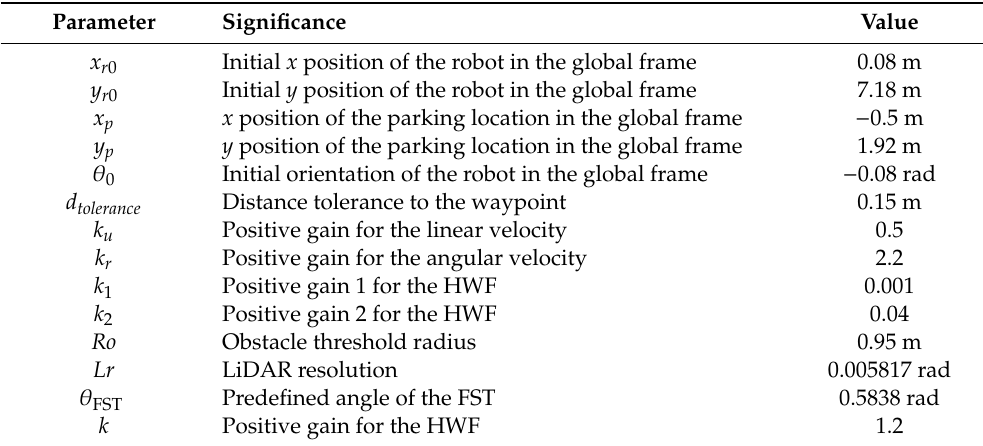
Table 2. Experimental parameters used to test the HWF.